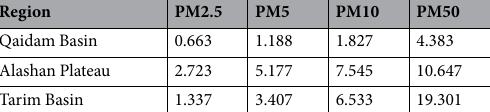
Region PM2.5 PM5